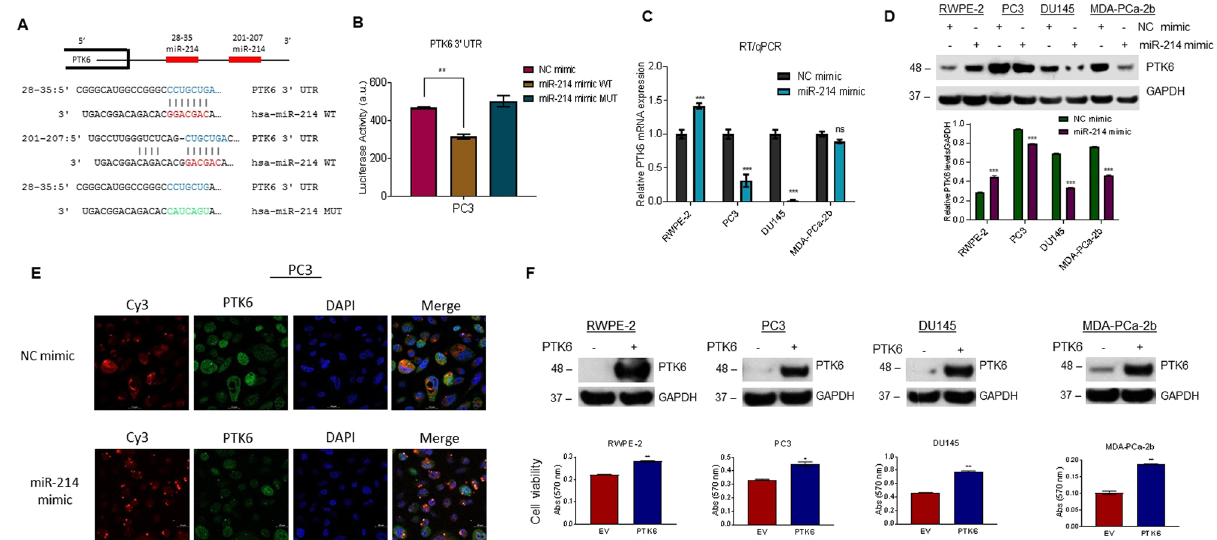
Figure 4. miR-214 targets PTK6 and inhibits its expression. ( A) The binding sites of miR-214 in the 3 ′ UTR region of PTK6 were analyzed by TargetScan (http://www.targetscan.org/vert_72/) and presented (top). We mutated the binding nucleotides of miR-214 to the 3 ′ UTR region of PTK6 to generate a mutant miR-214 mimic. Constructs of the wild-type and mutant miR-214 mimics are shown (bottom). (B) Luciferase reporter assay: PC3 cells were first transfected with one µ g of PTK6-3 ′ UTR-Luciferase reporter construct for 18 h and then transfected with NC, wild-type miR-214, or mutant miR-214 mimic for an additional 24 h. Transfected cells were lysed, and luciferase activity was then measured. ** P < 0.005 compared with NC or wild-type miR- 214 mimic. ( C ) RWPE-2, PC3, DU145, and MDA-PCa-2b cells were transfected with NC or miR-214 mimic. After 48 h, relative PTK6 expression was analyzed by RT/qPCR. *** P < 0.0005 compared with NC-transfected cells. (D) RWPE-2, PC3, DU145, and MDA-PCa-2b cells were transfected with NC or miR-214 mimic. After 48 h, PTK6 protein levels were analyzed by western blotting (top) and quantified using ImageJ (bottom). *** P < 0.0005 compared with NC-transfected cells . (E) PC3 cells were transfected with NC or miR-214 mimic for 48 h, and then PTK6 expression (green) was visualized by immunofluorescence as described in the materials and methods section. ( F ) RWPE-2, PC3, DU145, and MDA-PCa-2b cells were transfected with PTK6 plasmid or empty vector plasmid, and expression of PTK6 protein levels were analyzed by western blotting (upper panel). Effect of PTK6 overexpression on cell viability of prostate cancer cells was measured by MTT assay and plotted (lower panel). The data represent mean ± SEM. One-way ANOVA with Tukey’s multiple comparisons test was used to determine statistical significance for RT/qPCR and western blot